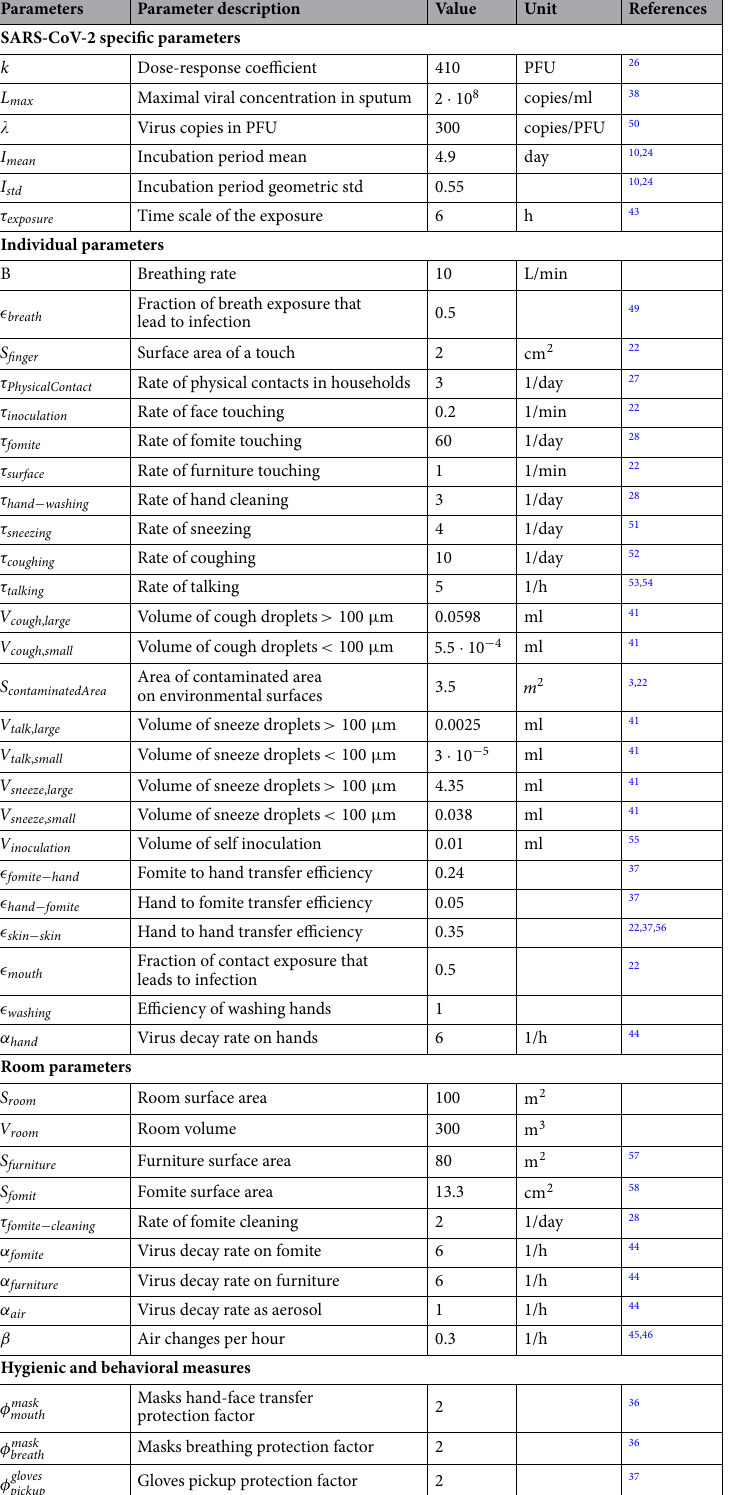
Table 2. The model parameters for the reference